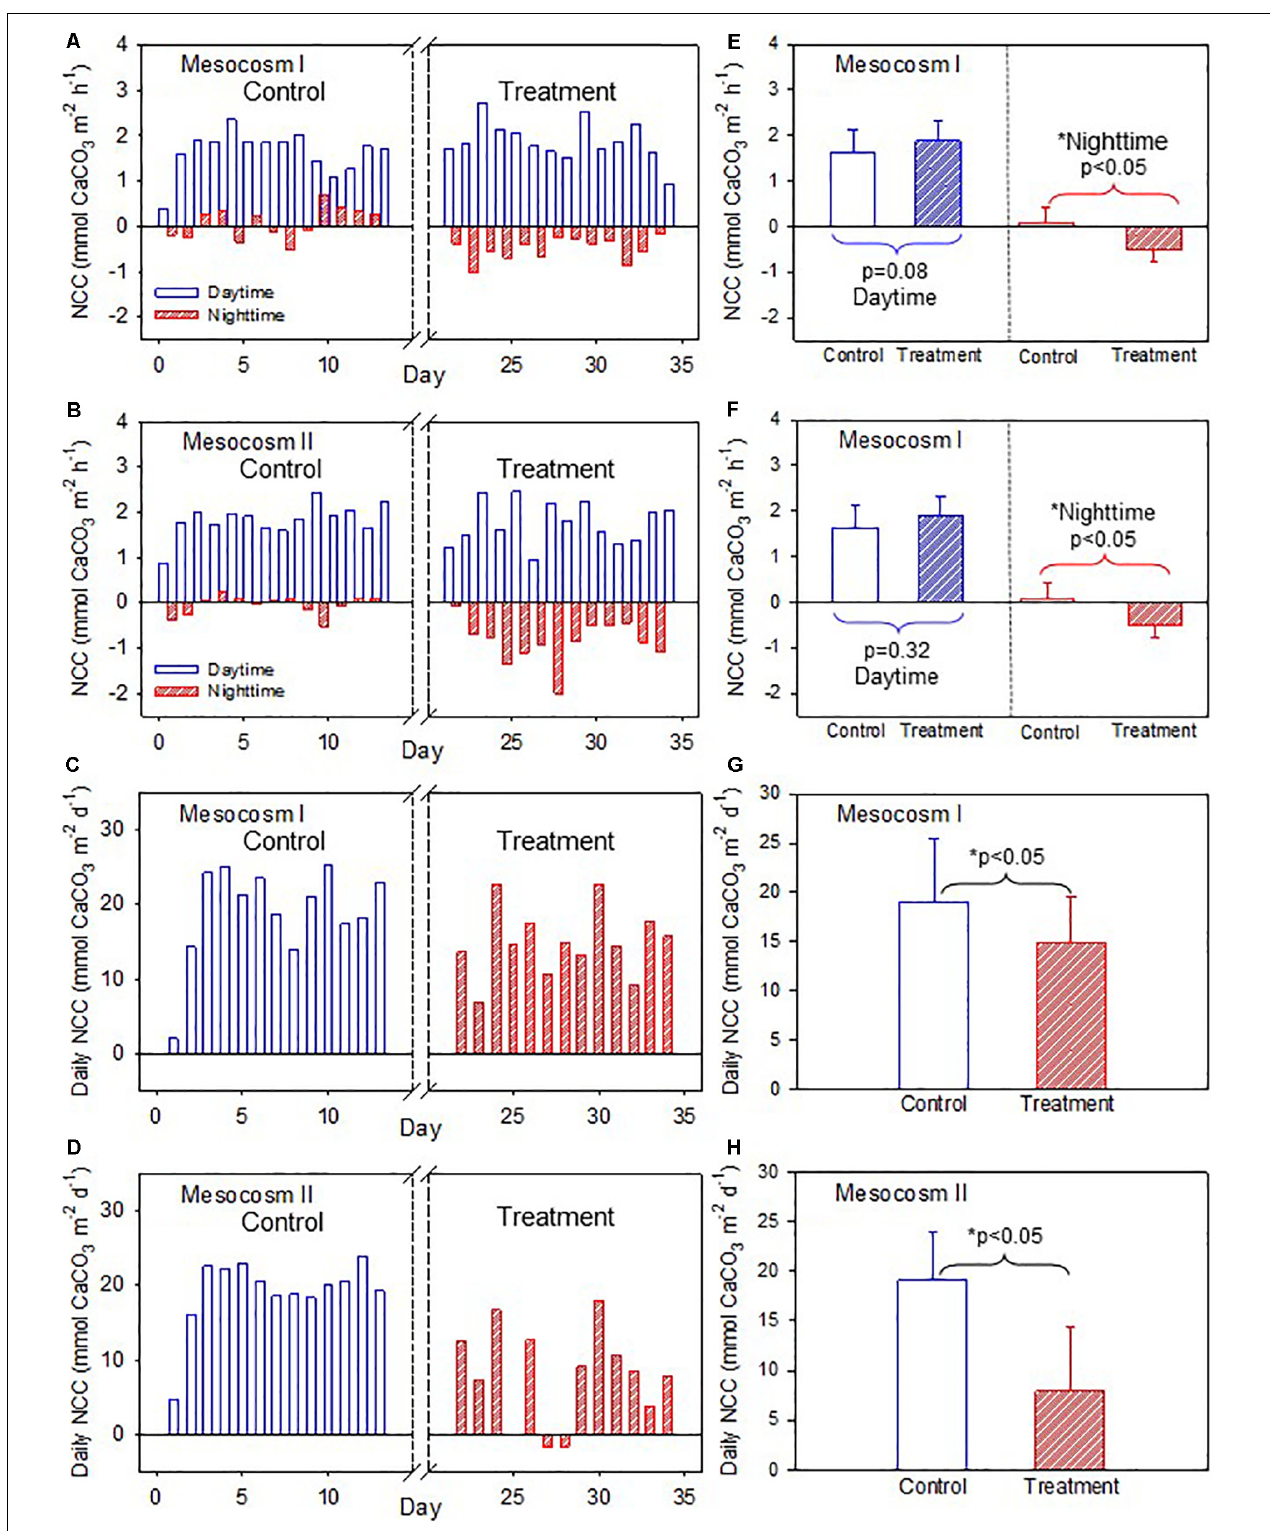
FIGURE 3 | (A , B) Temporal variations of daytime and nighttime net community calcification (NCC), and (C,D) daily NCC in mesocosms I and II during the control and treatment periods. (E,F) Comparisons of average daytime and nighttime NCC, and (G,H) average daily NCC in mesocosms I and II between the control and treatment periods by the Student’s t -test. The asterisks indicate that the difference is statistically significant ( p -value < 0.05).